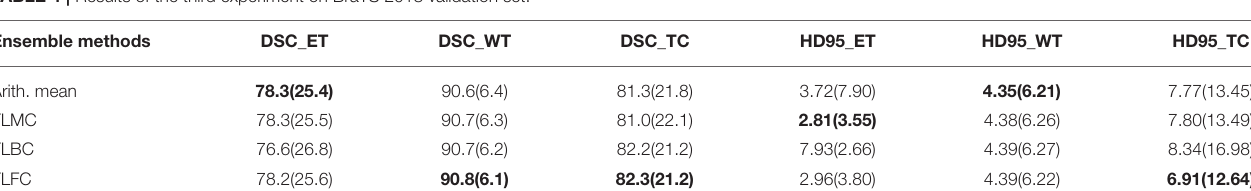
TABLE 4 | Results of the third experiment on BraTS 2018 validation